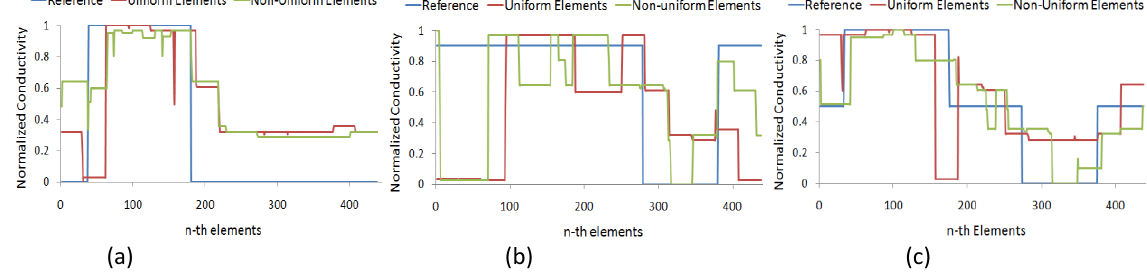
Figure 11: The line profiles of the reconstruction image from uniform and non-uniform elements compared to reference. (a) Insulator, (b) conductor, and (c) insulator-conductor